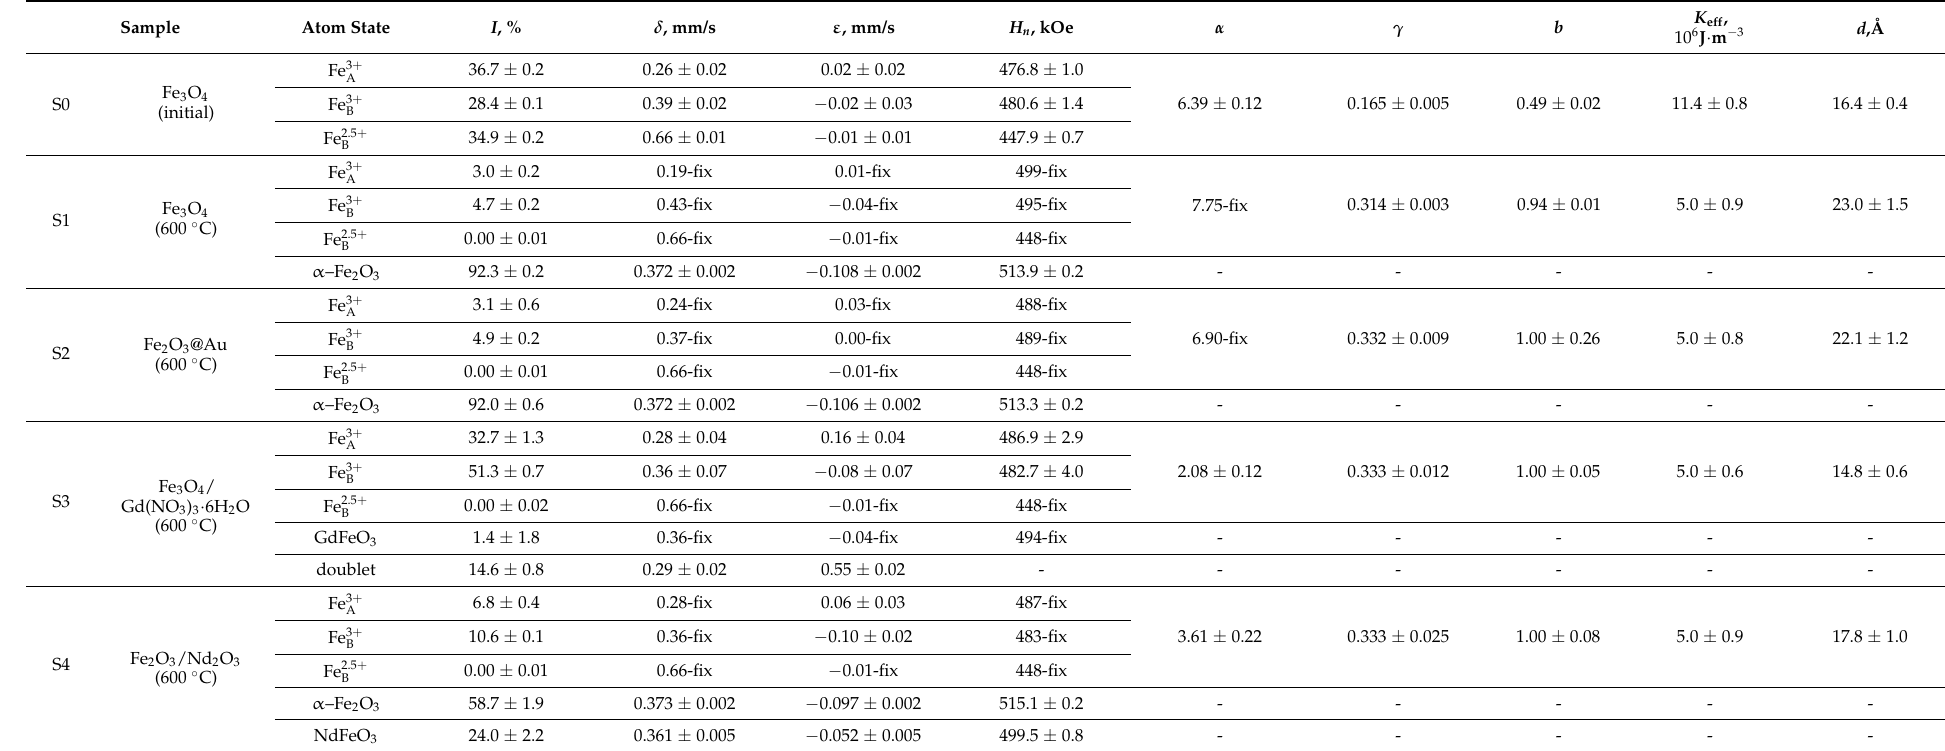
Table 1. Model interpretation results of the Mössbauer spectra of the studied